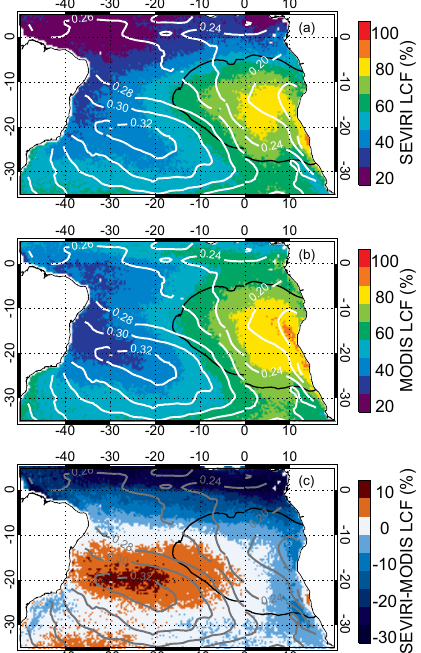
Fig. S4. The peak of the LWP absolute difference as